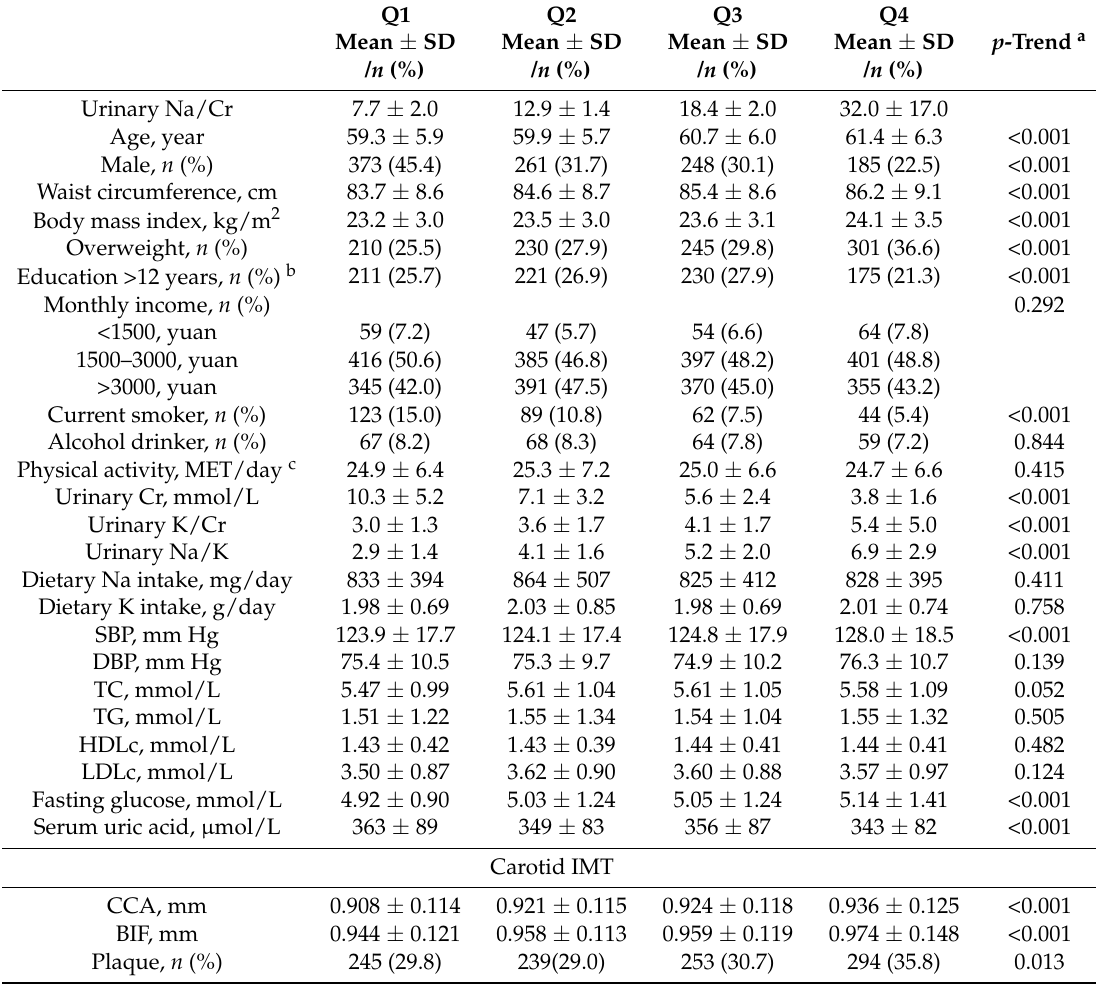
Table 1. Characteristics of participants by quartiles (Q) of urinary Na/Cr ( n =